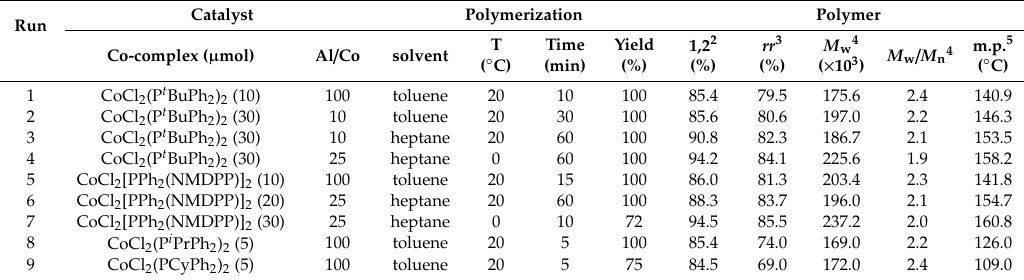
Table 2. Polymerization of 1,3-butadiene with cobalt catalytic systems. 1.